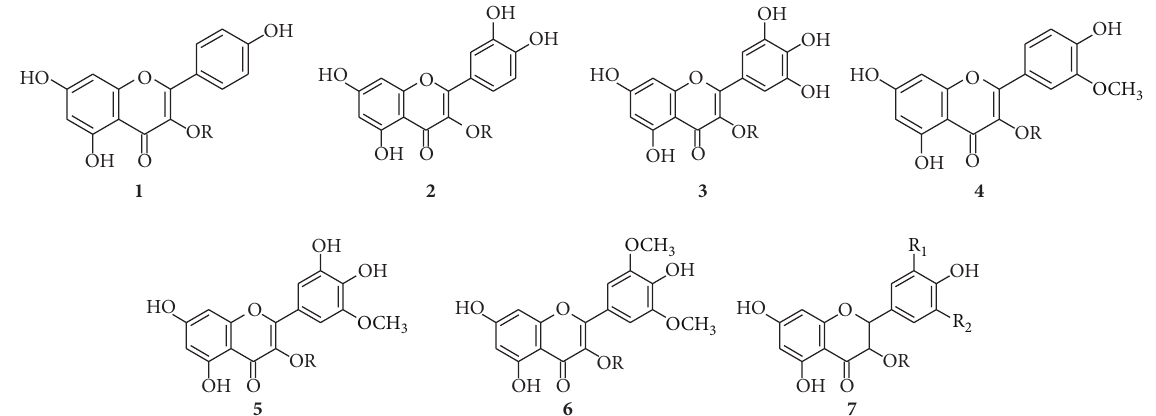
Figure 1: Main flavonols in grape. R: galactose, glucose, glucuronic acid, and rutinose; R 1 : H, OH, and OCH 3 ; R 2 : H, OH, and OCH 3 ; (1) kaempferol, (2) quercetin, (3) myricetin, (4) isorhamnetin, (5) laricitrin, (6) syringetin, and (7) dihydroflavonol.